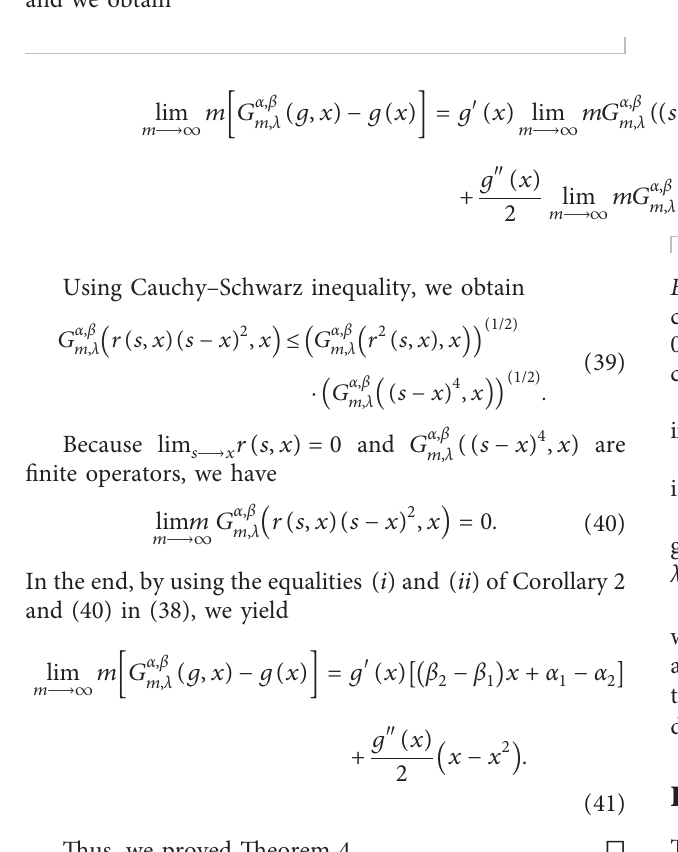
( f, x ) , B 1 ( f, x ) , and B 1 m, 1 20 , 10 , 11